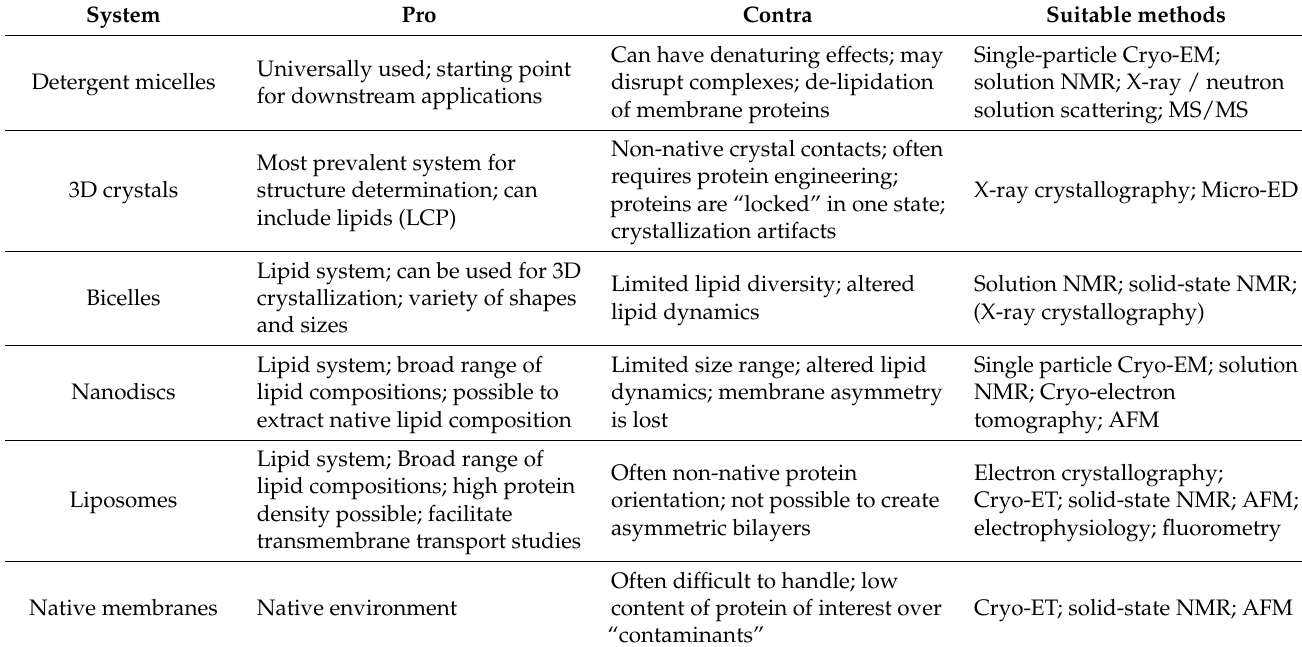
Table 1. Pros and cons of different membrane